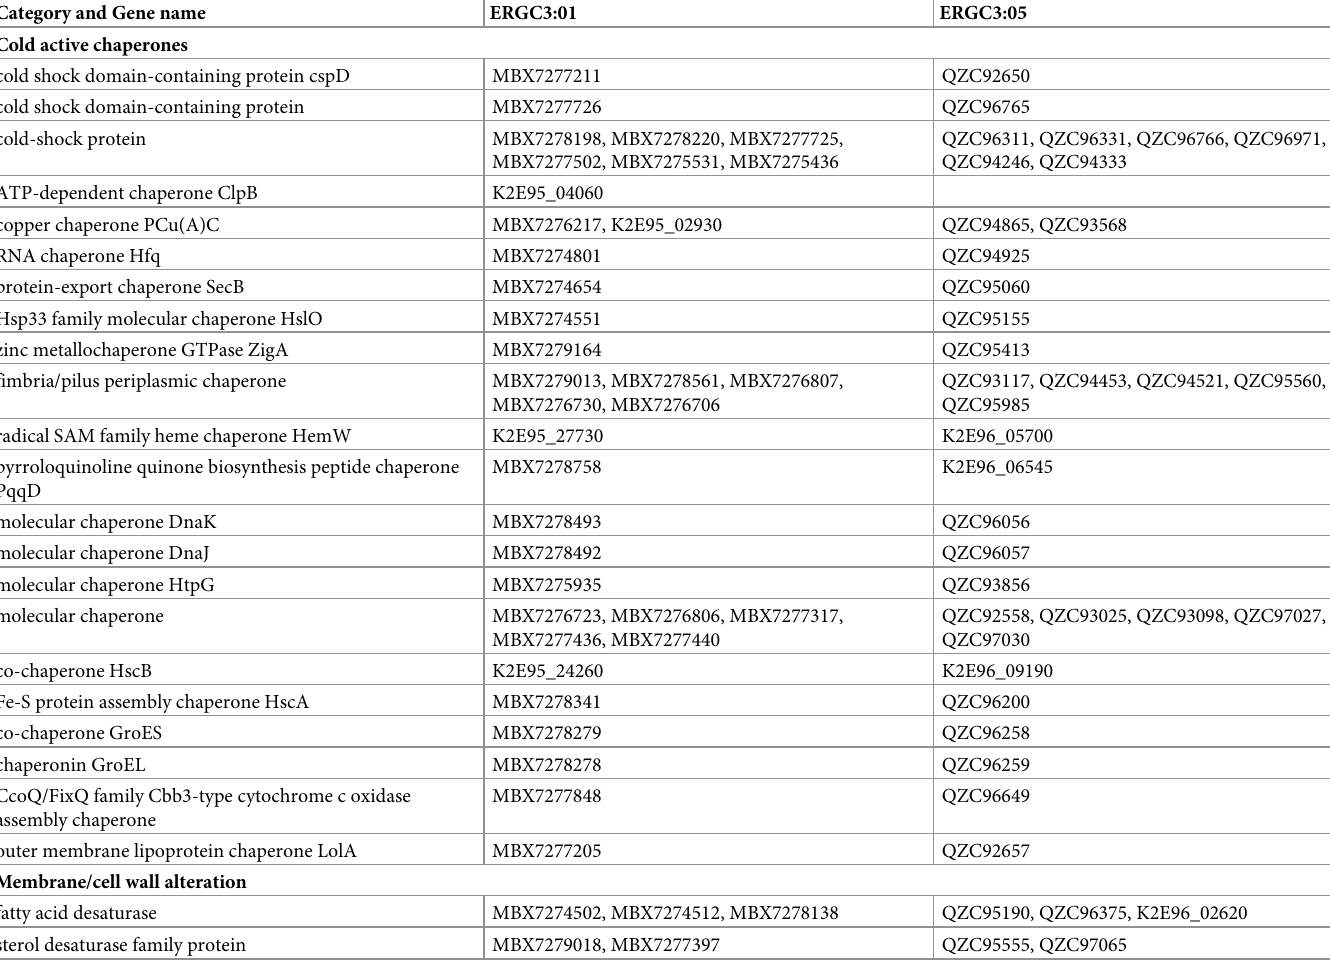
Table 3. Genes encoding known cold & stress response and DNA repair proteins with accession number/locus tag as predicted in the genomes of Pseudomonas sp. ERGC3:01 and